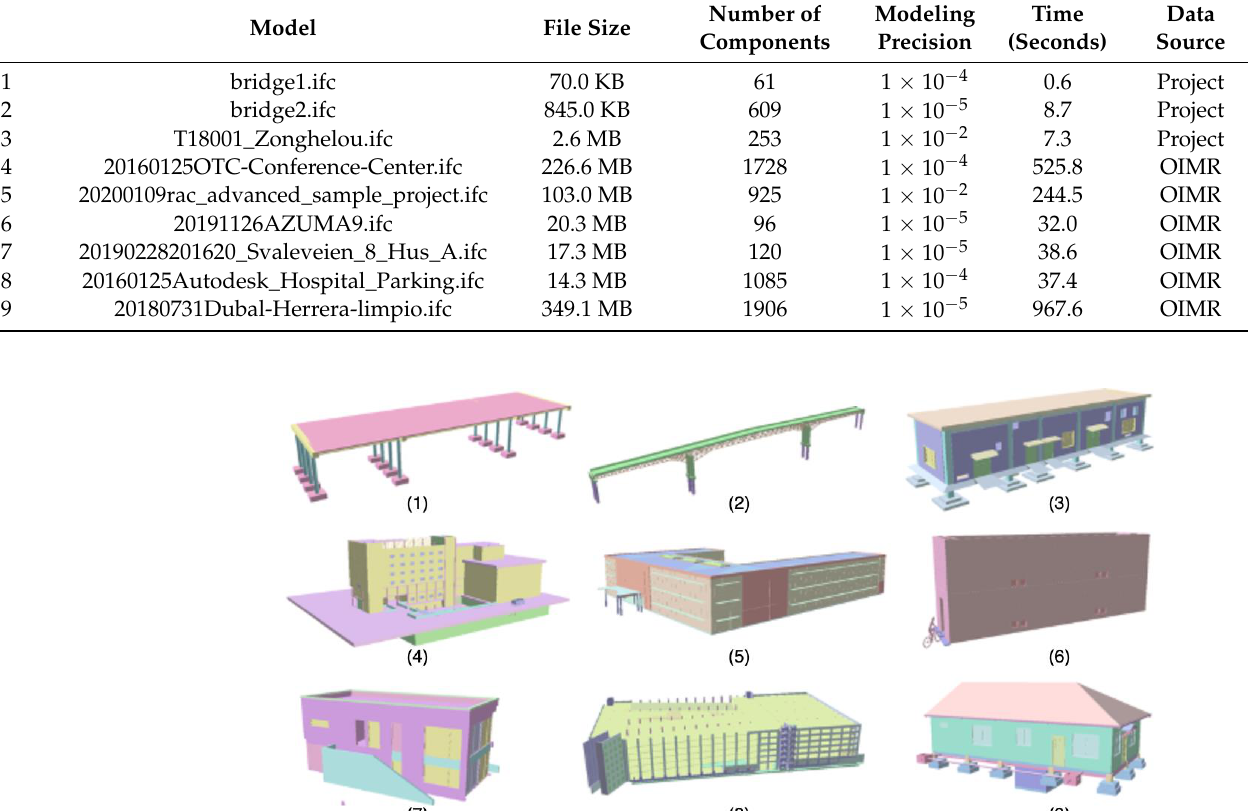
Table 12. Additional BIM models used in validation.